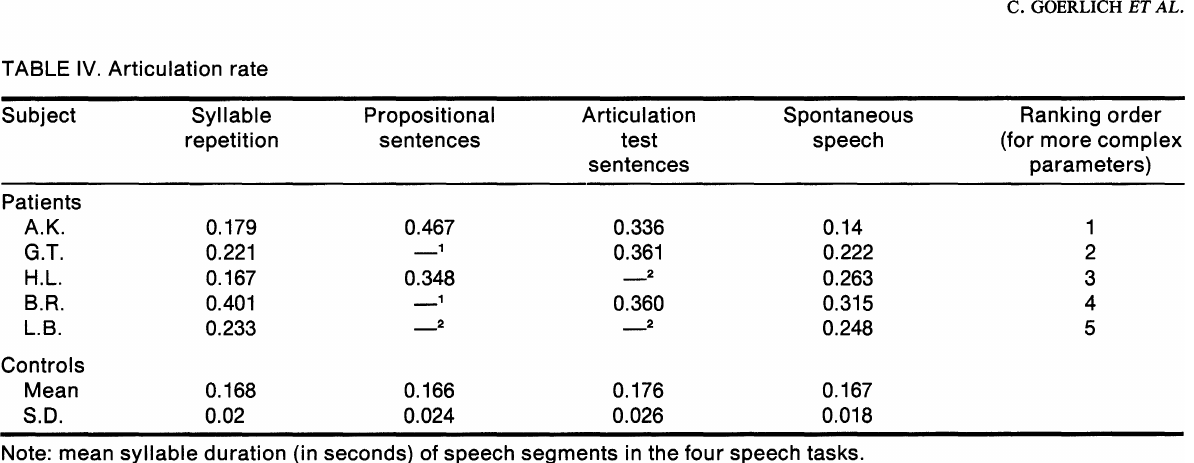
TABLE IV. Articulation